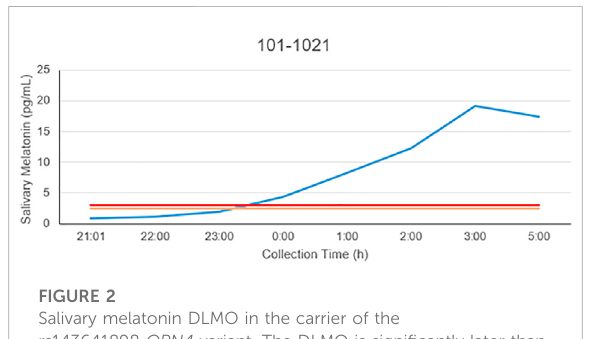
FIGURE 2 Salivary melatonin DLMO in the carrier of